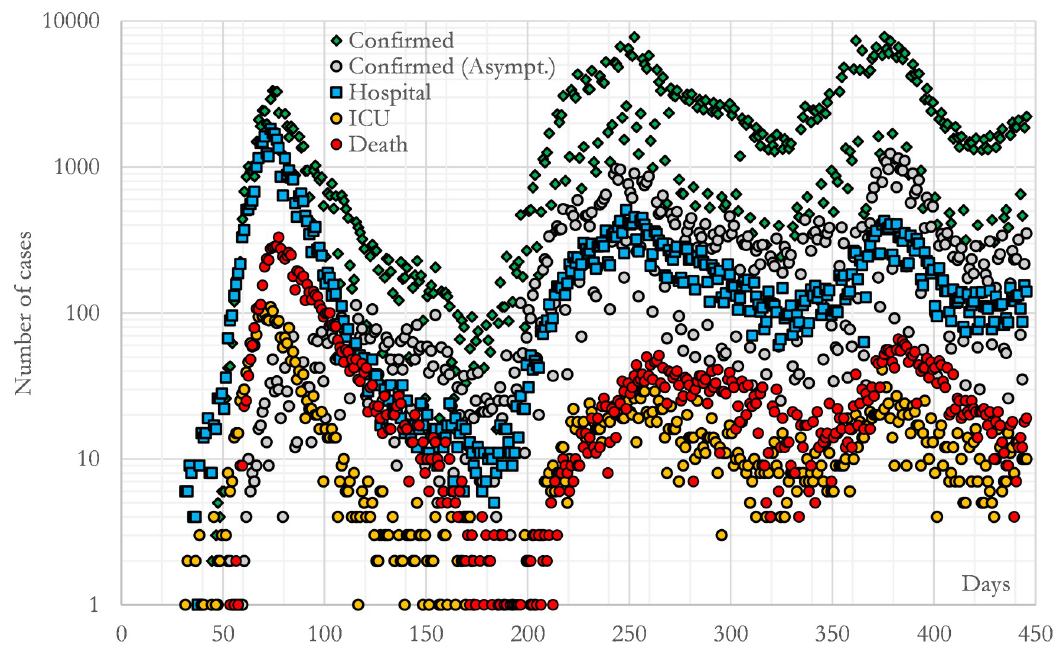
Fig 3. Evolution of confirmed, asymptomatic, hospitalized, ICU and death cases during the studied period in the region of Madrid (CM). Data come from SISPAL as explained in the text. The main dispersion in the data comes from the delay in reporting cases during the weekend. This effect moves some Saturday and Sunday cases towards